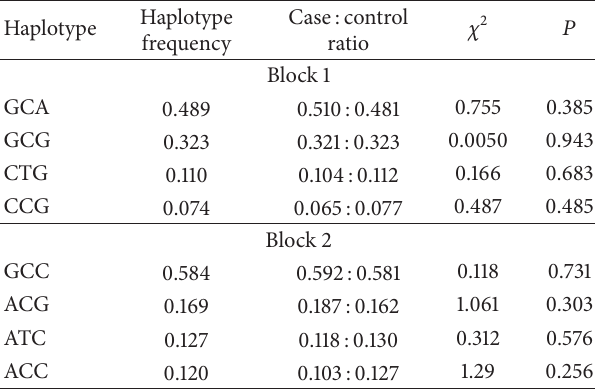
Table 5: Comparison of haplotype frequencies for the analysed CRHR1 polymorphisms between patients with suicide attempts and the control group.